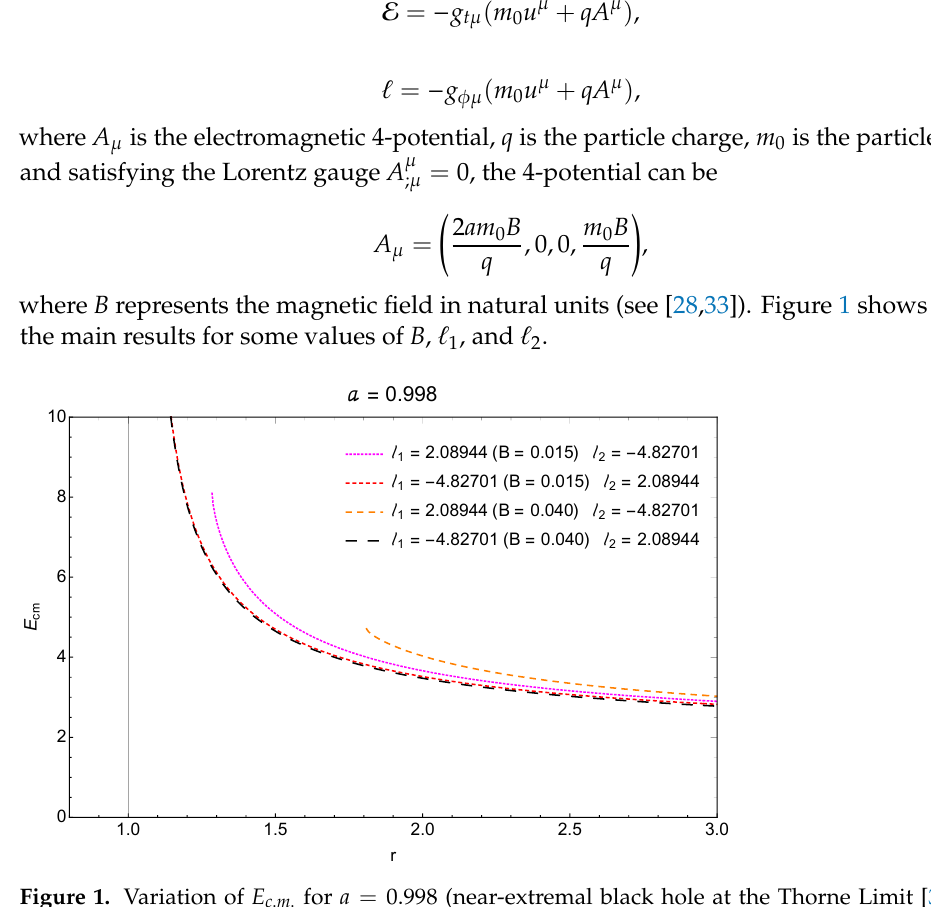
Figure 1. Variation of E c . m . for a = 0.998 (near-extremal black hole at the Thorne Limit [34]) for four di ff erent values of the angular momentum for neutral-charged particles in the presence of B = 0.015 and B = 0.040 magnetic fields (in natural units, see [28,33]). Before the horizon, the colliding particles are accelerated to infinity. The best results are obtained when the particles are orbiting in opposite